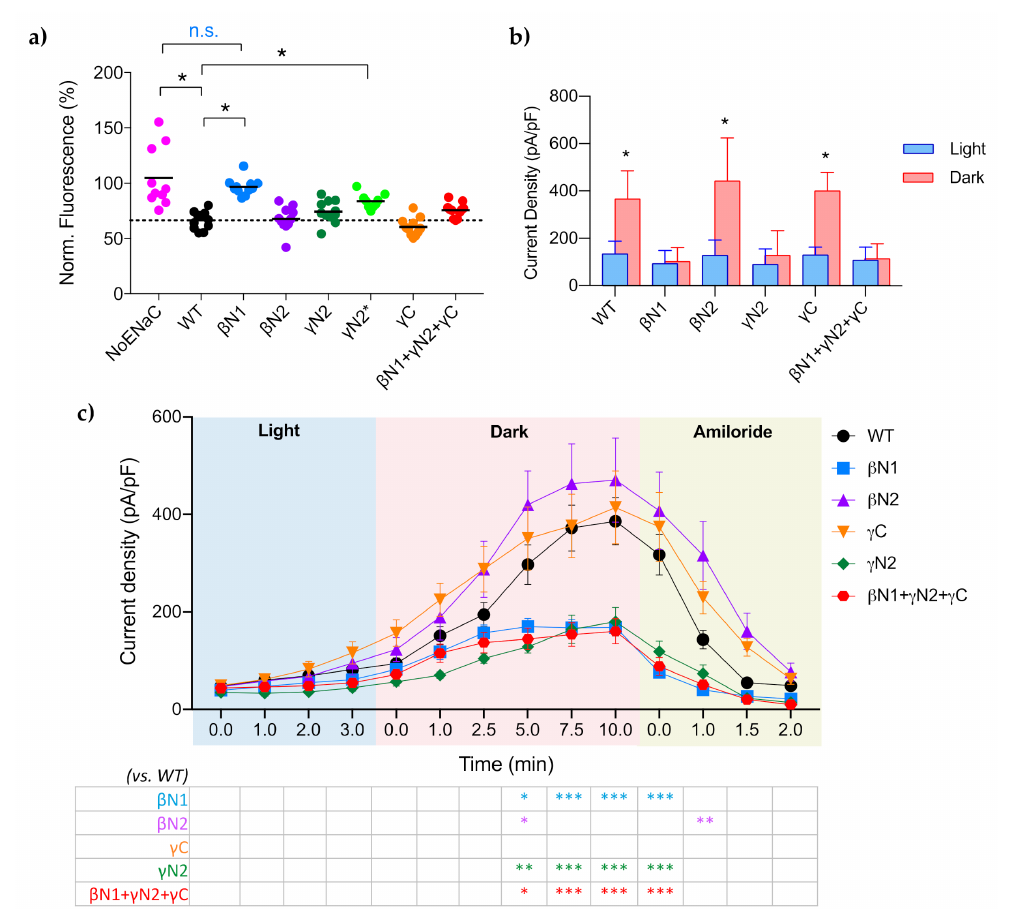
Figure 3. Summary of mutant-ENaC responses to PIP2 depletion and recovery. ( a ) Summary graph comparing the CoroNa Green intensity of cells expressing each mutant 10 min after BLI. *, p ≤ 0.0001, n.s., no significant difference. The dashed line indicates the mean CoroNa Green intensity of wtENaC 10 min after BLI. ( b ) Summary graph comparing the mean current densities ± SD of each ENaC under BLI-induced PIP2 depletion (Light/blue) and PIP2 recovered (Dark/red). *, p < 0.0001, comparing light to dark. ( c ) Summary timeline of the current density of each mutant ENaC in response to recovery of PIP2 levels after CRY2-OCRL relocation to the cytoplasm, expressed as the mean of 5–7 cells ± SEM. Two-way ANOVA (column factor, mutant; row factor, time) indicated significant differences between 5 min dark and 1 min after amiloride, where ***, p < 0.0001, **, p < 0.005, and *, p < 0.05, compared to wtENaC, noted in the table below the time